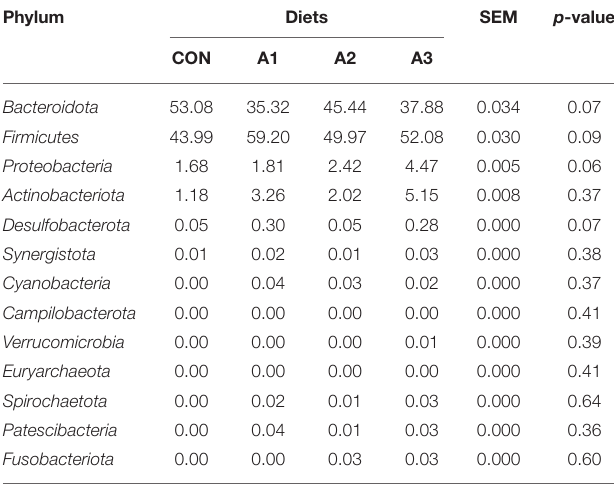
TABLE 4 | Effects of Anemoside B4 on the comparison of dominant phylum of suckling calves at 28 days of age (%). Phylum Diets SEM p -value